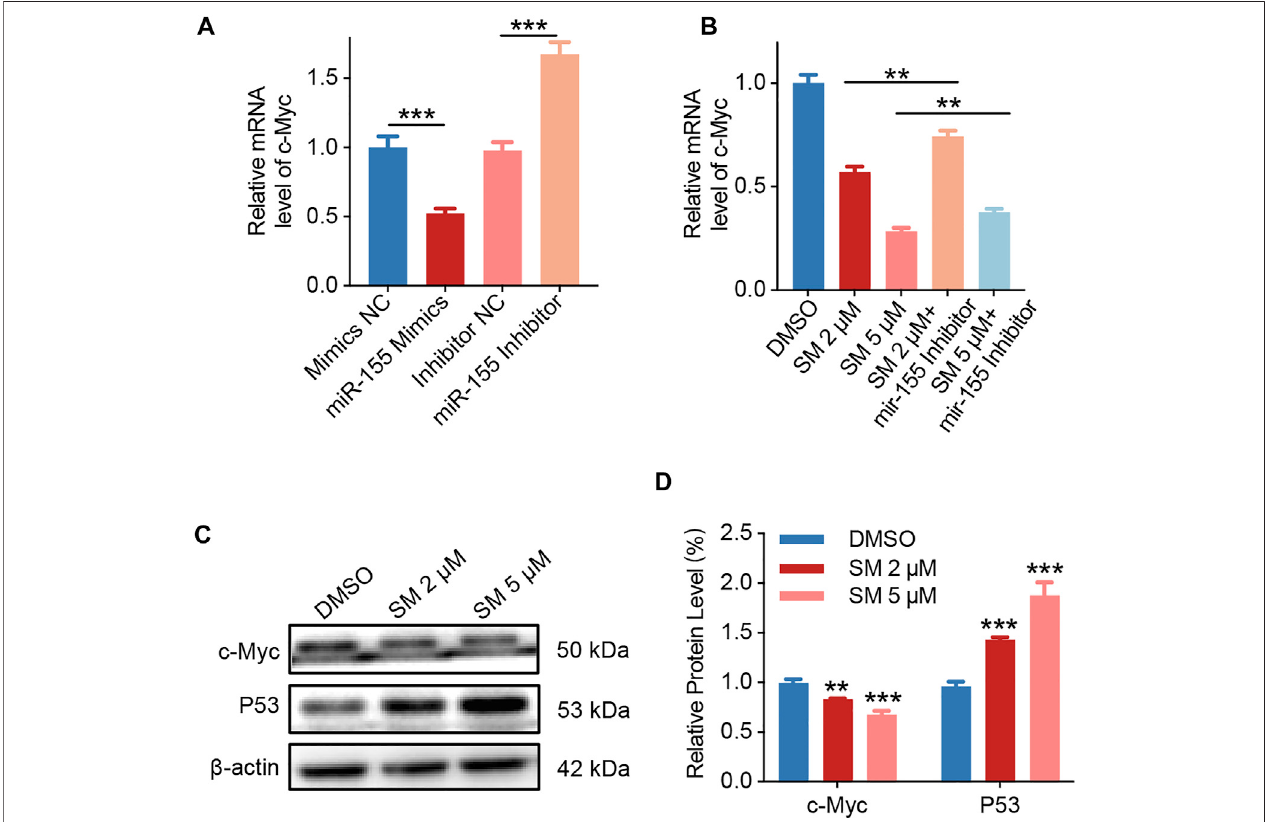
FIGURE 5 | SM induces apoptosis via lncRNA HOXA11-AS / miR-155 / c-Myc. (A) Relative expression of c-Myc in FaDU cells was analyzed by RT-PCR after being transfected with the miR-155 mimic and inhibitor. (B) Relative expression of c-Myc in FaDU cells was analyzed by RT-PCR after being transfected with the miR-155 inhibitor and treated with 2 and 5 μ M SM. (C,D) Immunoblotting assay analysis of c-Myc and P53 in FaDU cells treated with DMSO and 2 and 5 μ M SM. The grayscale values of the strips were analyzed with ImageJ software. **( p < 0.01) and ***( p < 0.001) indicate statistically signi fi cant differences.